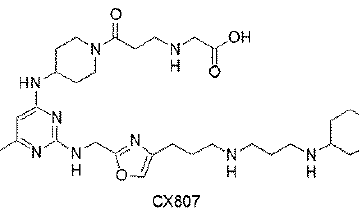
Figure 1. Chemical structure of CX807.